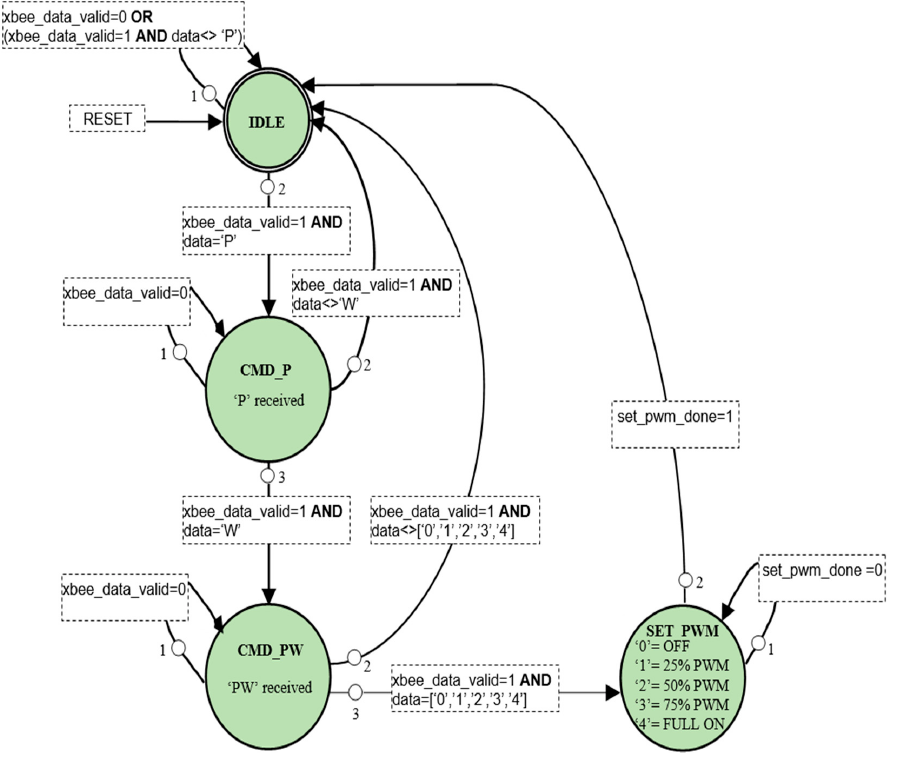
Figure 8. State diagram of PWM control logic.